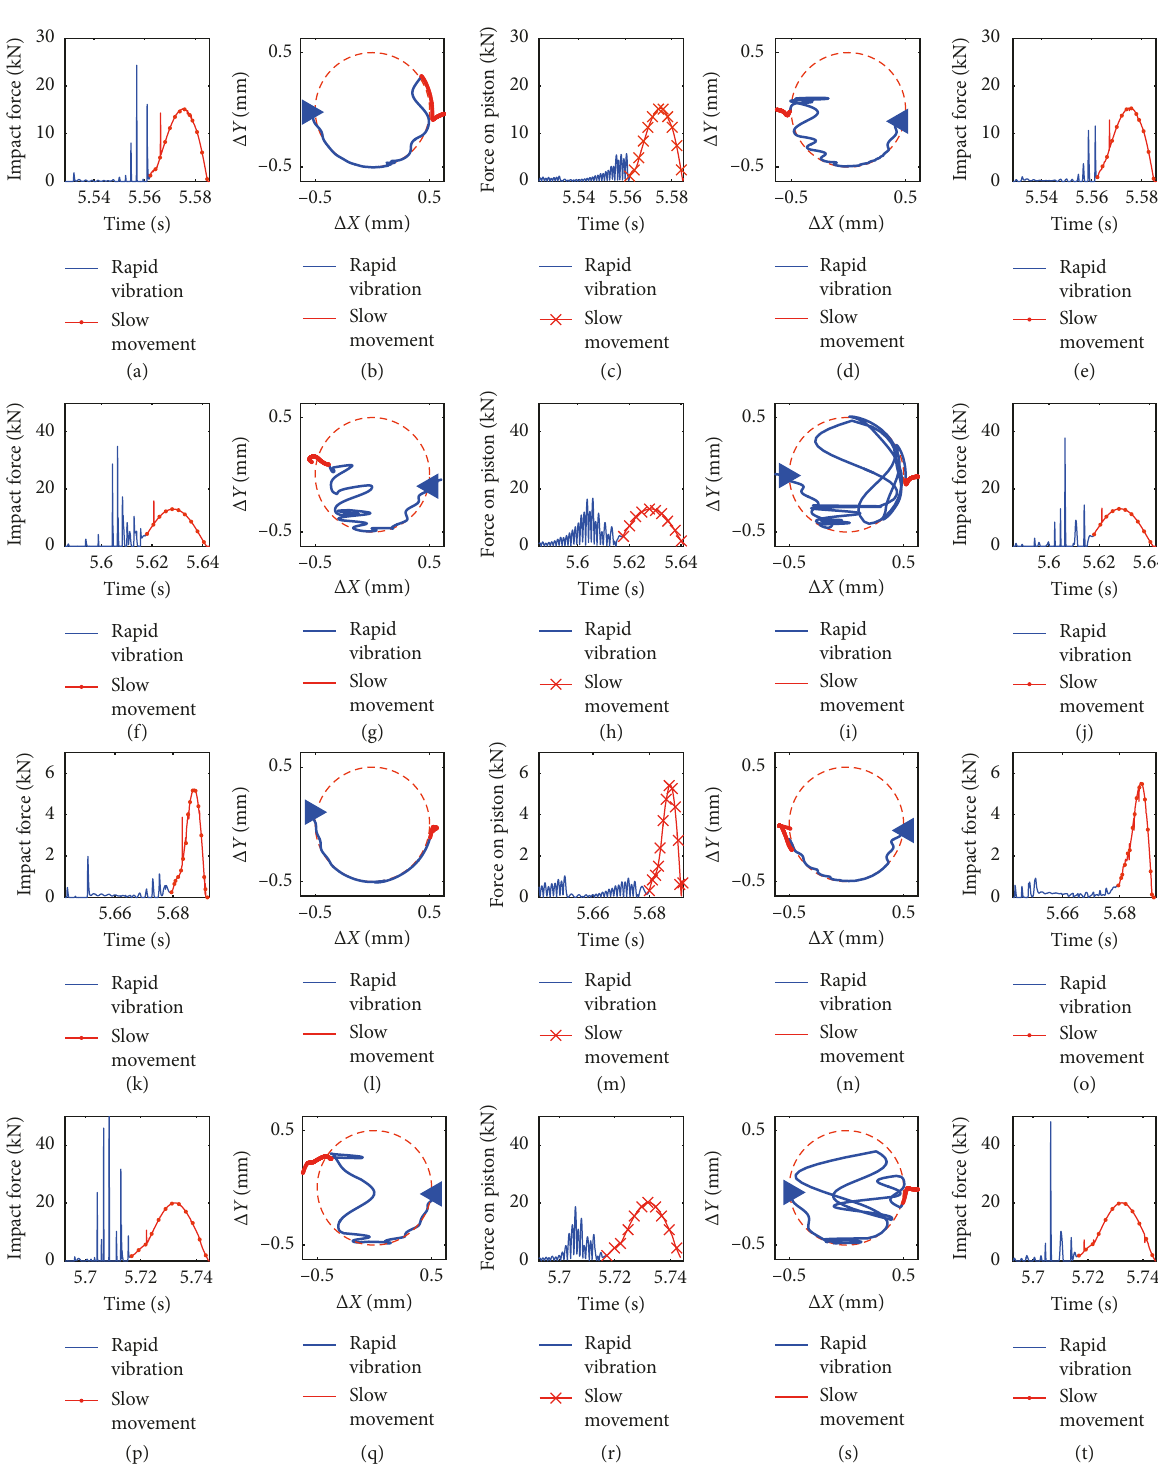
3 impact force, (b, g, l, q) clearance P 3 trajectory, (c, h, m,